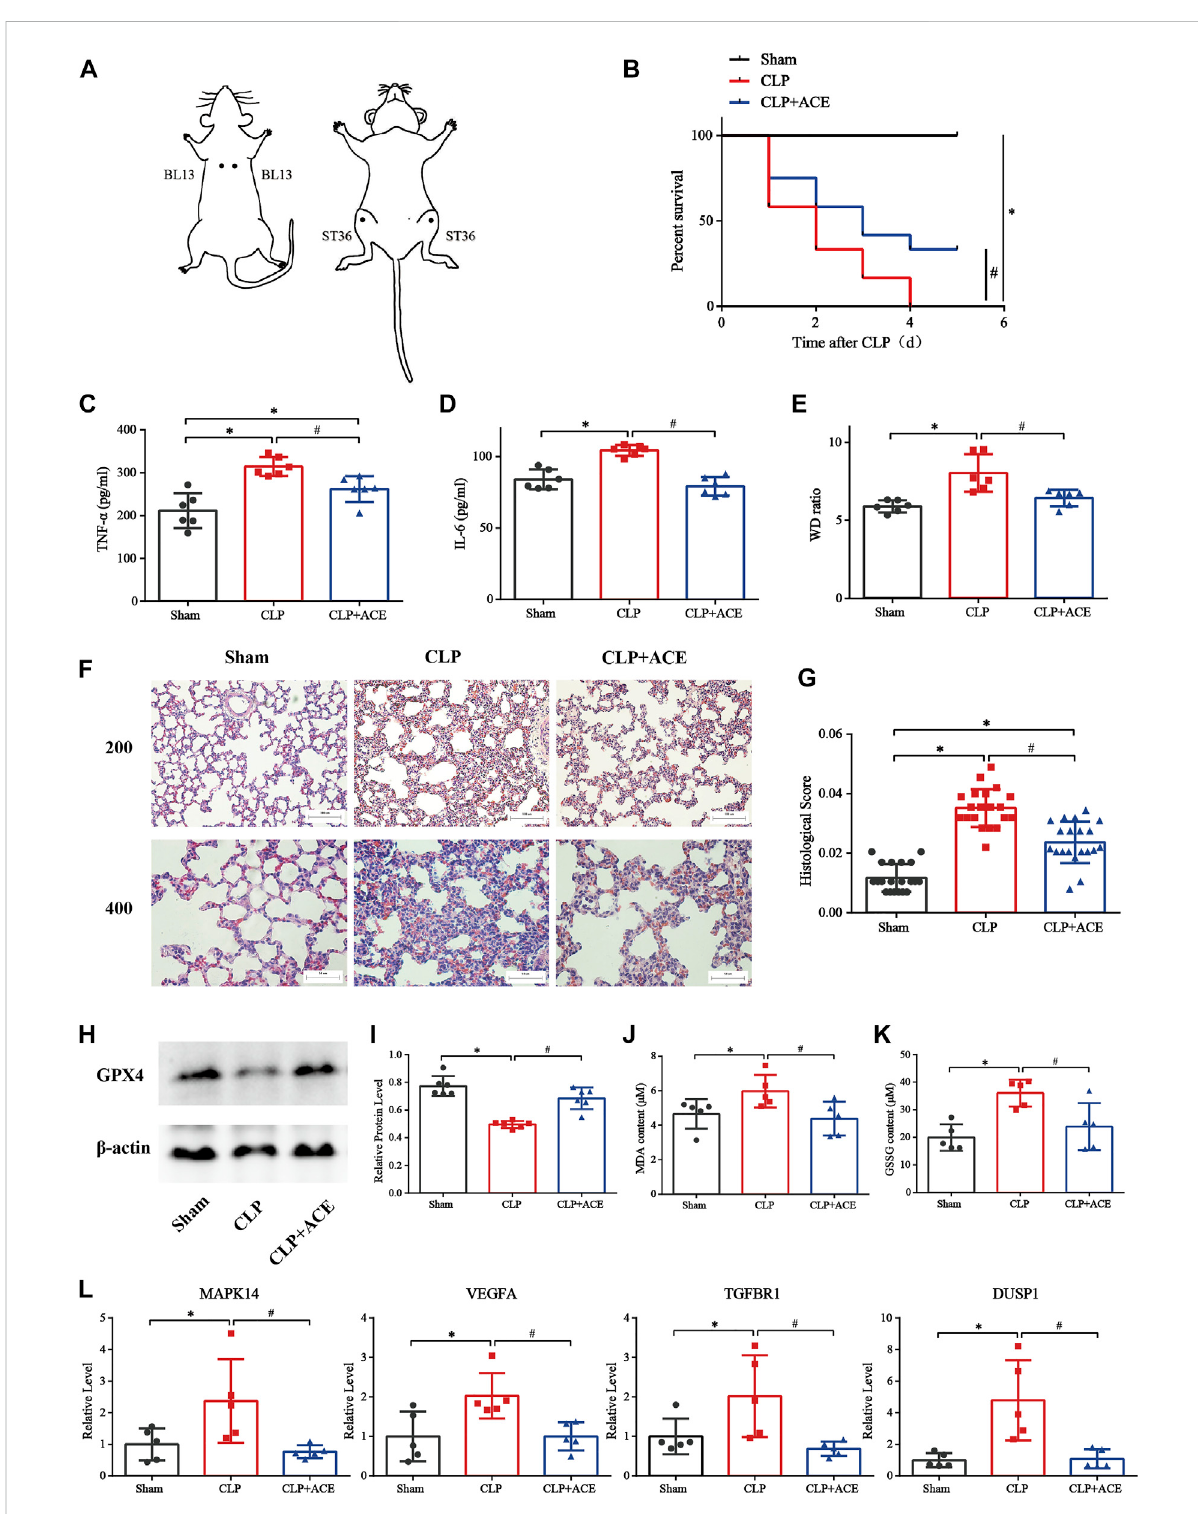
FIGURE 7 Effectofacupointcatgutembedding(ACE)onsepsis-inducedacutelunginjury(siALI)ratsandferroptosis. (A) Acupointlocation(schematic). (B) ACE increased the 5-day survival of siALI rats ( n = 12 per group). (C) TNF- α level in serum. (D) IL-6 level in serum. (E) W/D ratio in lungs. (F) H&E staining of pulmonary sections: scale bar is 50 µm or 100 µm. (G) Lung-injury scores. (H,I) Western blotting shows that ACE upregulated of GPX4 expressionin thelungs of siALI rats. (J,K) Levels of GSSG and MDA were measured using assay kits. (L) qRT-PCR shows that expression of MAPK14 , VEGFA , TGFBR1 , and DUSP1 was higher in siALI rats than that in the sham group. After ACE, expression of these four genes was downregulated. Data are the mean ± SD ( n = 5 or 6 per group). p p < 0.05 vs . sham group, # p < 0.05 vs . CLP